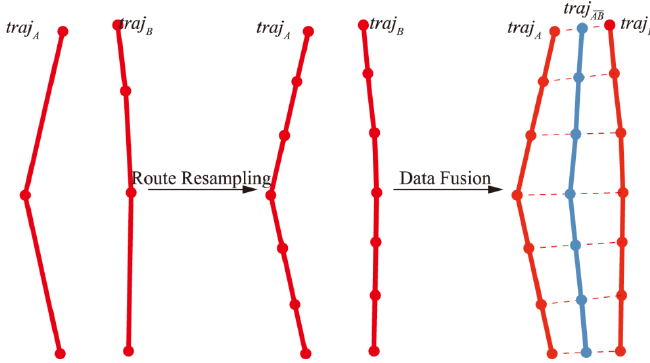
Figure 7. Ship trajectory fusion extraction.